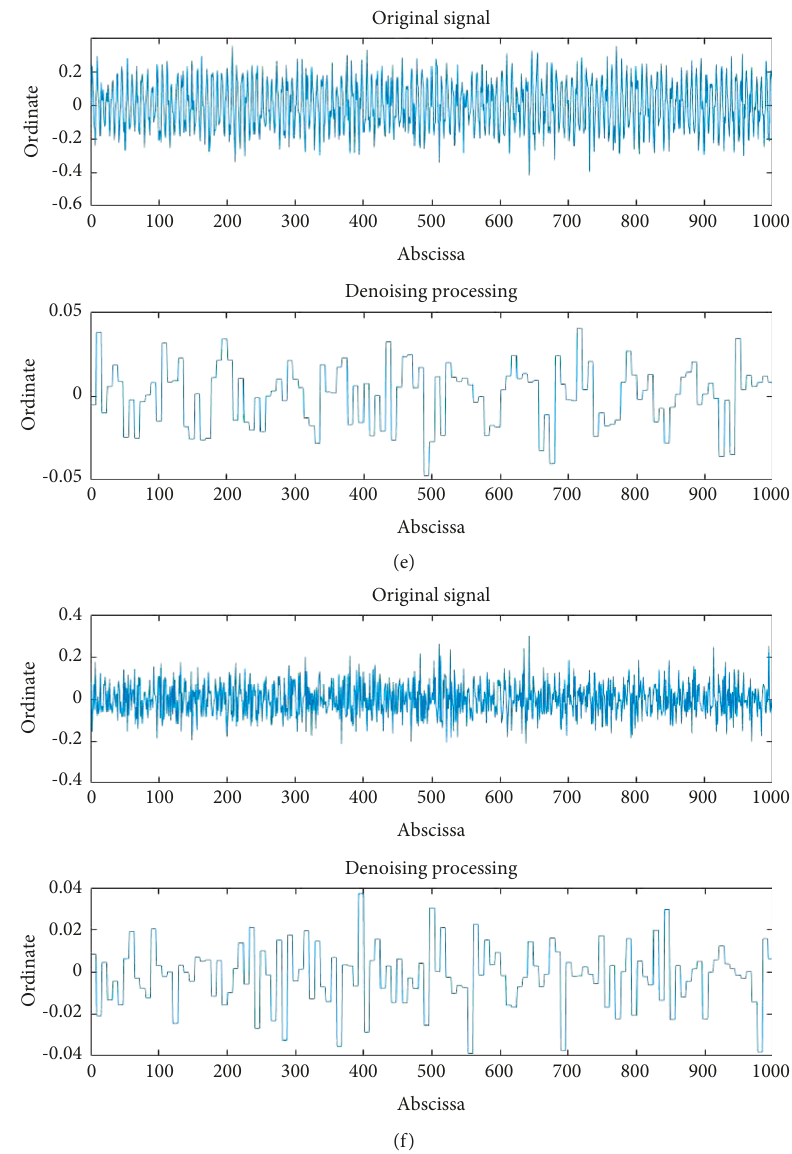
Figure 5: Contrast waveform of vibration signals before and after denoising. (a) X direction at the inlet of 1# unit; (b) Y direction at the inlet of 1# unit; (c) X direction at the inlet of 3# unit; (d) Y direction at the inlet of 3# unit; (e) X direction at the inlet of 4# unit; (f) Y direction at the inlet of 4#